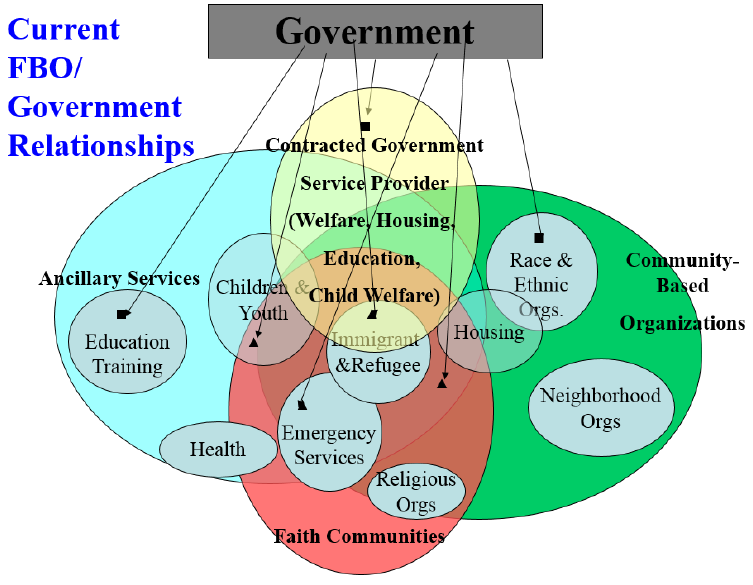
Figure 1. Current faith ‐ based organization (FBO)/government relationships.